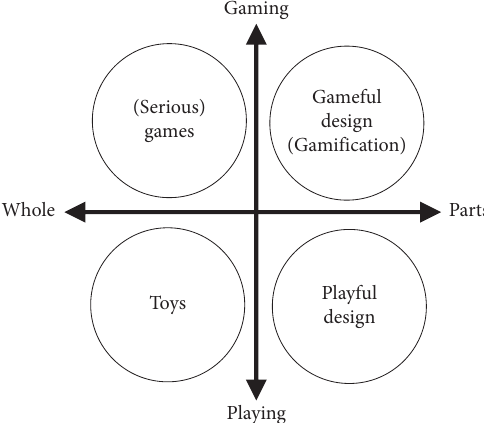
Figure 2: Whole versus parts and gaming versus playing as two dimensions distinguish game-related concepts